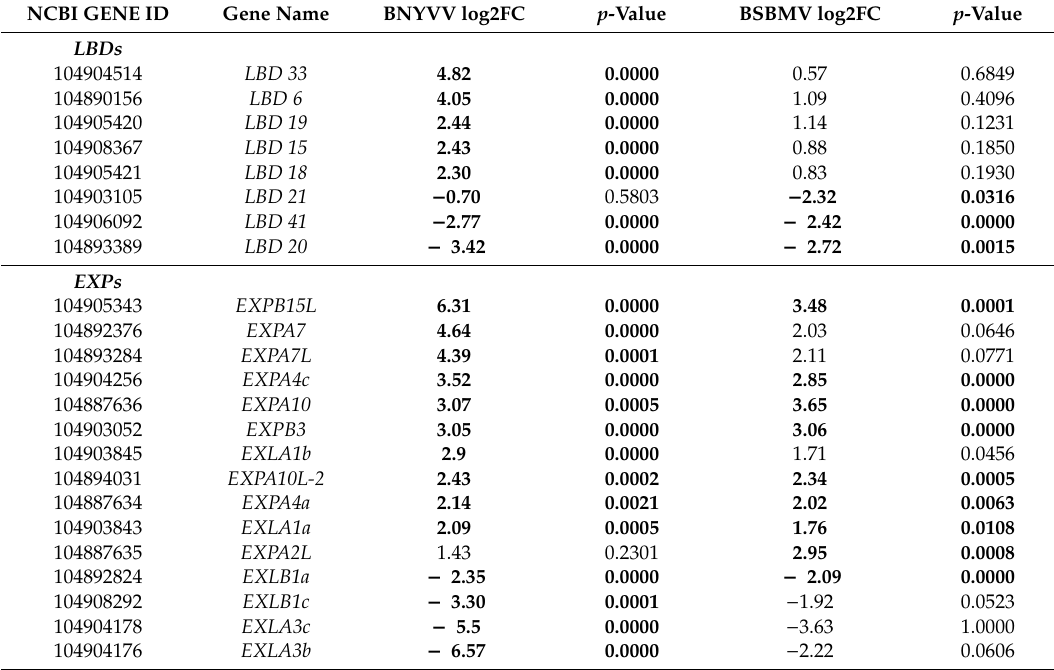
Table 4. Log2 fold change (log2FC) of di ff erentially expressed lateral organ boundaries domain ( LBDs ) and expansin ( EXPs ) genes in BNYVV- and BSBMV-infected plants. The data that are statistically supported ( p > 0.05) with a log2FC > 2 are highlighted in